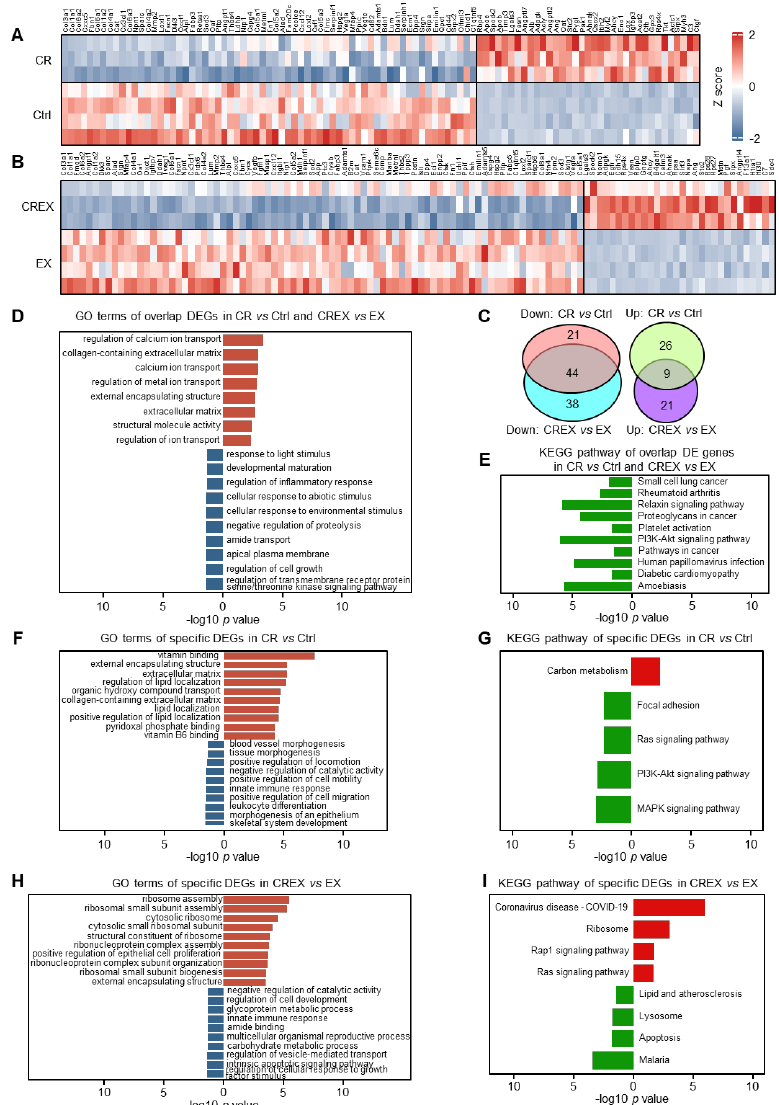
Figure 5. GO terms and KEGG pathways enriched for DEGs encoding myokines upon CR with or without EX. ( A , B ) Heatmap plots of DEGs encoding myokines in the CR vs. control groups ( A ) and in the CREX vs. EX groups ( B ). ( C ) Venn plot of common and distinct DEGs encoding myokines upon CR with or without EX. ( D ) Enriched GO terms for common DEGs encoding myokines in the skeletal muscle upon CR with or without EX. ( E ) Enriched KEGG pathways for common DEGs encoding myokines in the skeletal muscle upon CR with or without EX. ( F ) Enriched GO terms for specific DEGs encoding myokines in the skeletal muscle upon CR without EX. ( G ) Enriched KEGG pathways for specific DEGs encoding myokines in the skeletal muscle upon CR. ( H ) Enriched GO terms for specific DEGs encoding myokines in the skeletal muscle upon CR with EX. ( I ) Enriched KEGG pathways for specific DEGs encoding myokines in the skeletal muscle upon CR with EX. Brick red, enriched GO terms for upregulated DEGs encoding myokines; navy blue, enriched GO terms for downregulated DEGs encoding myokines; bright red, enriched KEGG pathways for upregulated DEGs encoding myokines; green, enriched KEGG pathways for downregulated DEGs encoding myokines. 3.8. Cell Proportion Alterations resulting from CR and/or EX across the Two Tissues BAT and skeletal muscle are heterogeneous tissues with different cell types. We analyzed the cell proportions in BAT and skeletal muscle. To recognize the cell popula- tion compositions of the two tissues, we performed deconvolution analysis using